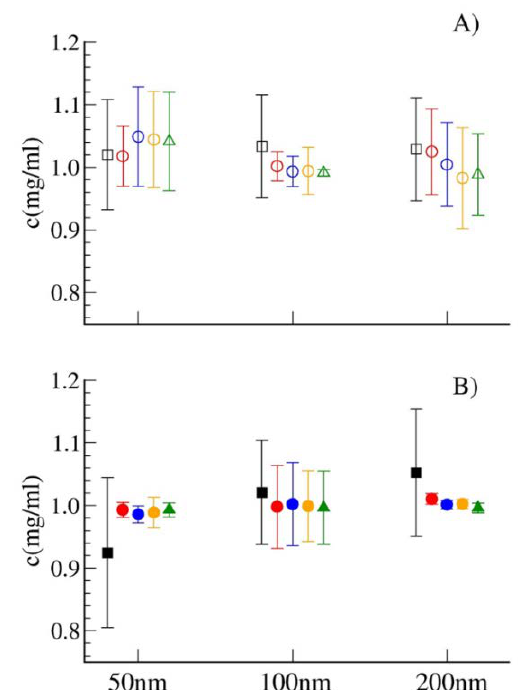
Figure 3. Di ff erent-sized vesicles’ weight concentrations. ( A ) POPC_LIPO and ( B ) MIX_LIPO. Stewart Assay (black squares) and the LS-method results, employing both an LS instrument at 60 ◦ , 90 ◦ and 120 ◦ (red, blue and orange circles, respectively) and a Spectrofluorimeter (green triangles). Errors of different magnitude for the different samples may arise from the small number of